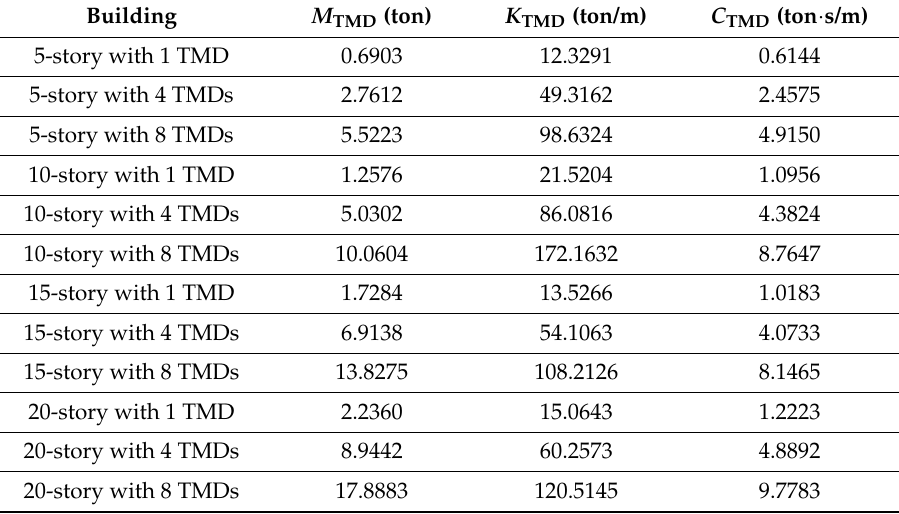
Table 2. Specifications of non-traditional tuned mass dampers (TMDs).